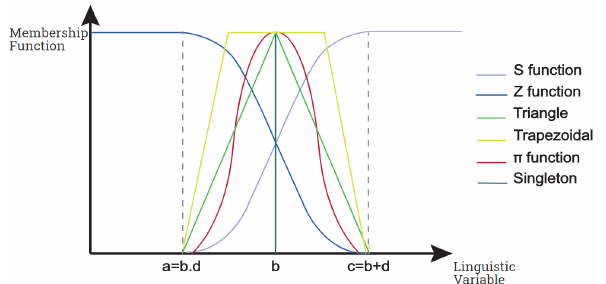
Figure 1. Membership function